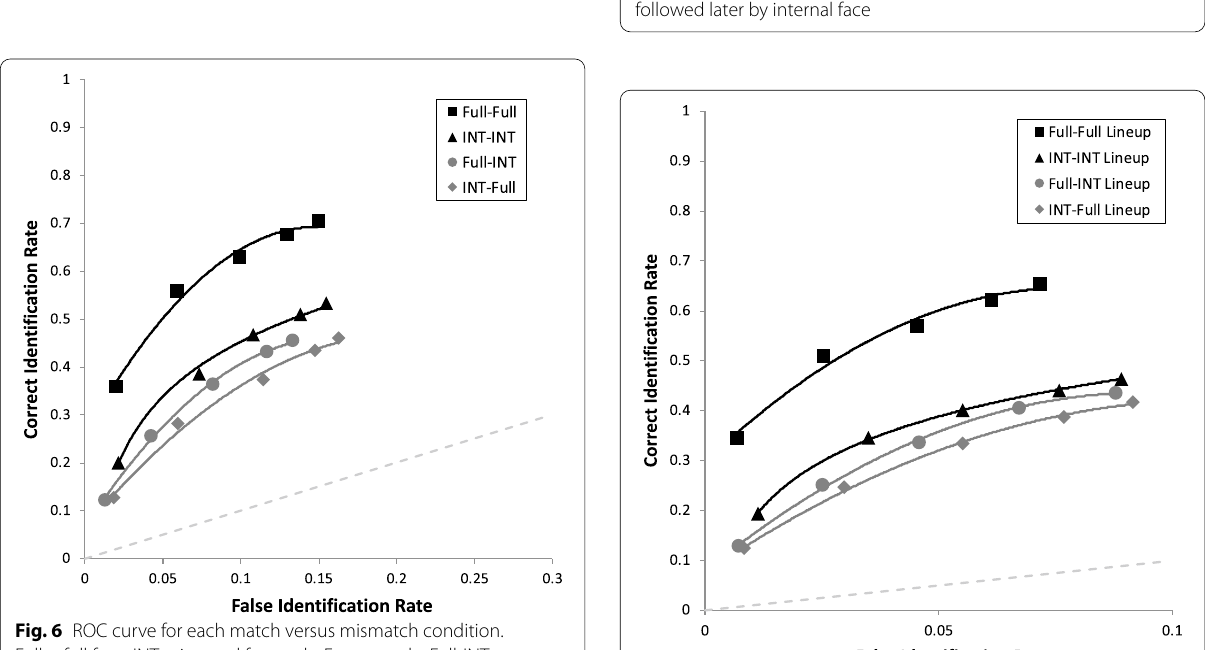
full face; INT internal face only. = =